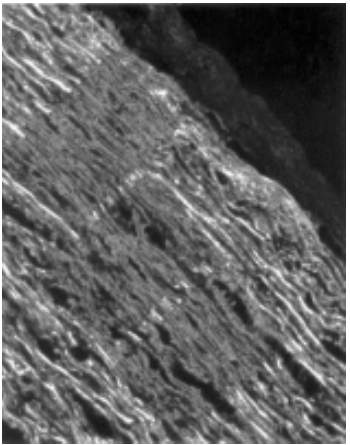
Fig. 4 - Computerized image of transversal histological section of the ascending artery of a patient with tricuspid aortic valve, internal portion of the media tunic of the vessel. Note the proximal areas to the intima layer, where the image analysis system measures the fibrillin-1. Transversal section of the ascending artery, indirect immunofluorescence utilizing monoclonal rat anti-fibrillin-1 antibody, magnification 20